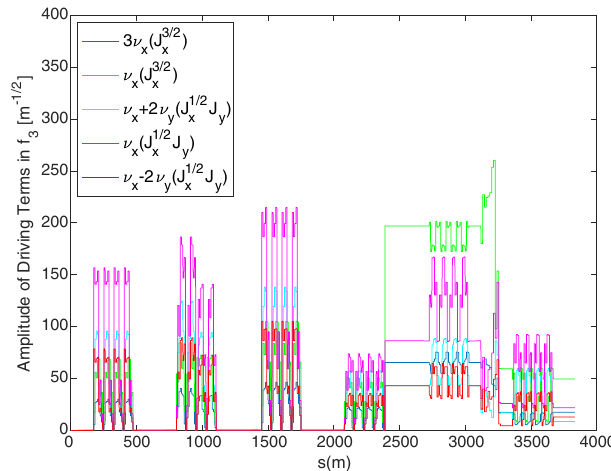
FIG. 11. The driving terms of the third-order resonances with correction by the harmonic sextupoles in the dispersion-free